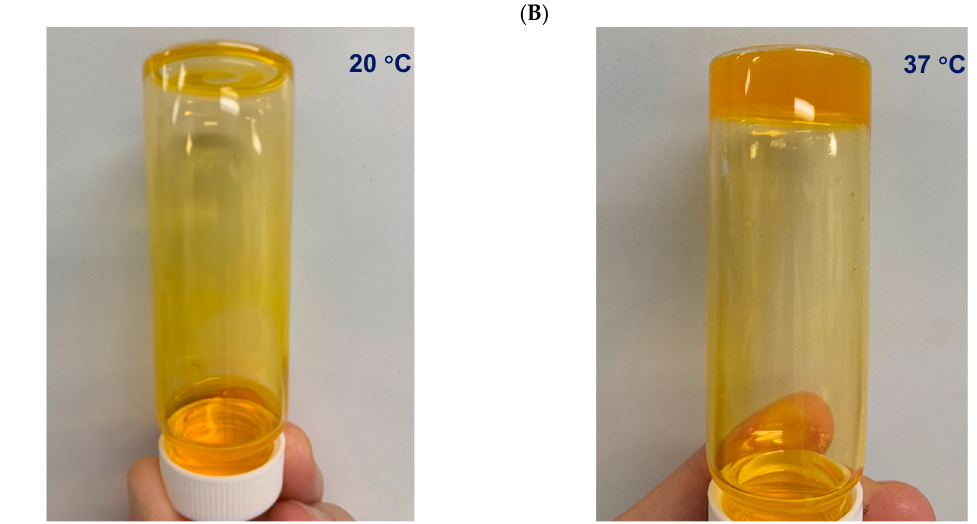
Figure 1. Methylcellulose (MC)-hyaluronic acid (HA) hydrogels (MCHA) incorporating fluorescein isothiocyanate-labeled bovine serum albumin (0.2% w / v ) at 20 °C ( A ) and 37 °C ( B ).